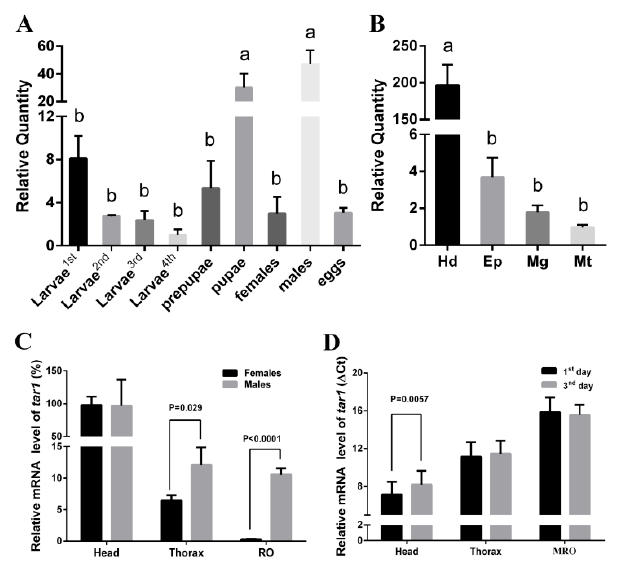
Figure 3. Relative expression (mean ± SE) of tar 1 in P. xylostella . ( A ) Expression of Pxtar1 genes in different development stages (first to fourth larvae, pre-pupae, pupae, adults, and eggs). Pxtar1 in fourth larvae was used as a comparator. ( B ) Expression of Pxtar1 in tissues (the head (Hd), epidermis (Ep), midgut (Mg), and Malpighian tubules (Mt)) of the fourth instar larvae. Pxtar1 in Mt was used as a comparator. ( C ) Expression patterns of Pxtar1 in adult tissues (head, thorax, female reproductive organs (FROs) and male reproductive organs (MROs)), Pxtar1 in FRO was used as a comparator. ( D ) Expression of the Pxtar1 in female adults in the head and MRO at first and third days. Data were mean values of three independent experiments ( n = 3) and normalized to endogenous ribosomal protein L32, the internal control